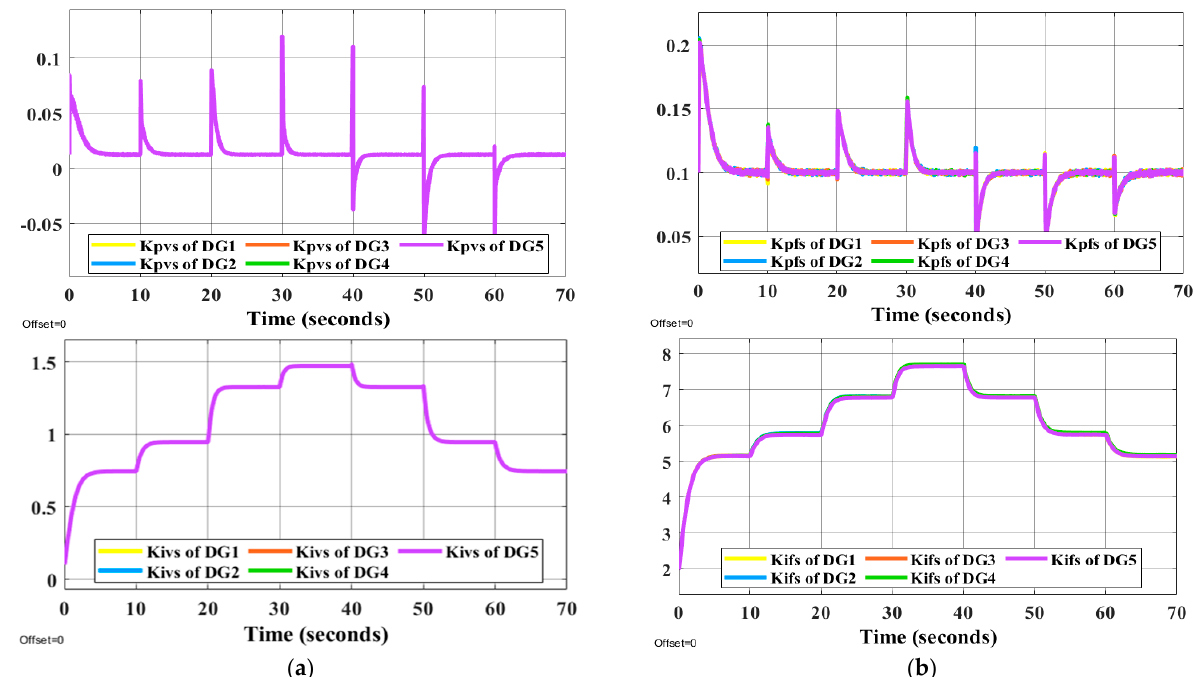
Figure 11. Updating the ( a ) voltage and ( b ) frequency parameters of the SCUs in DGs after the variations in loading conditions using ANN.